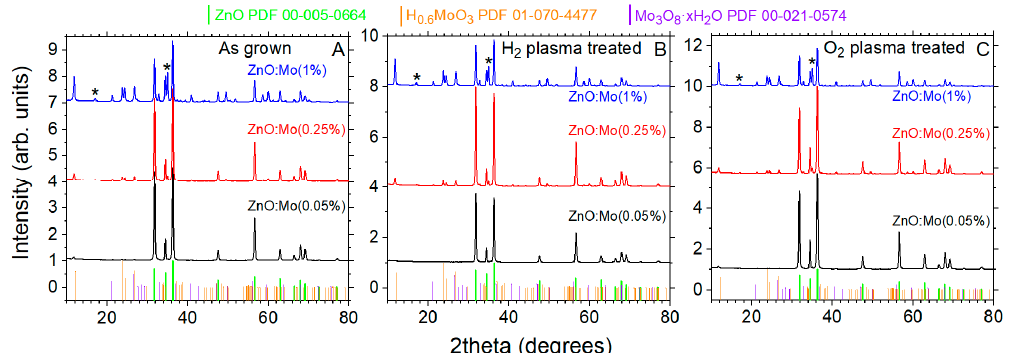
Figure 1. The XRD patterns of the ZnO:Mo(0.05, 0.25 and 1%) rods as grown ( A ), and H 2 ( B ) and O 2 ( C ) plasma-treated samples. The reflections of the hexagonal Wurtzite ZnO, H 0.6 MoO 3 and Mo 3 O 8 xH 2 O phases are additionally indicated. Asterisks (*) indicate possible Zn 2 Mo 3 O 8 phase oriented along {100} [33].